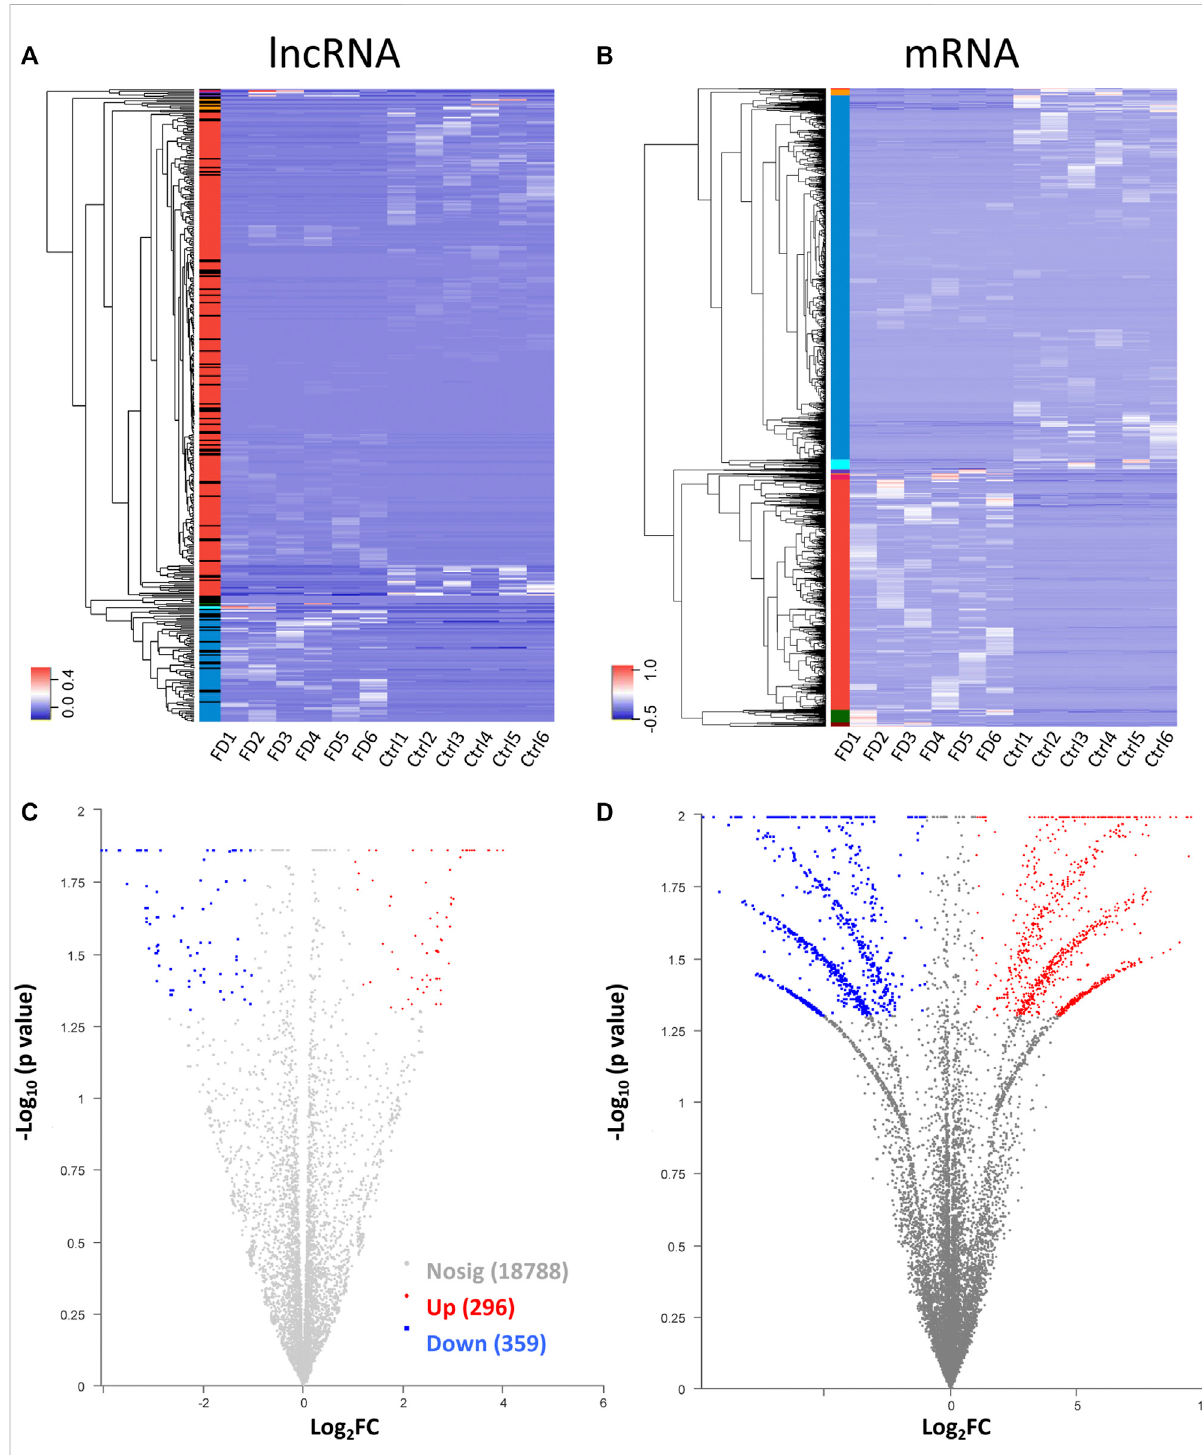
FIGURE 3 Heatmap for hierarchical clustering of lncRNAs (A) and mRNAs (B) from 12 samples (six for FDM and 6 for control). The colors in the panel represent the relative expression levels: blue and red represent low and high expressionlevels, respectively. Volcano plot of lncRNAs (C) and mRNAs (D) . Red/blue dots represent signi fi cantly up//downregulated RNAs (FC ≥ 2.0, p < 0.05). Gray indicates no differential